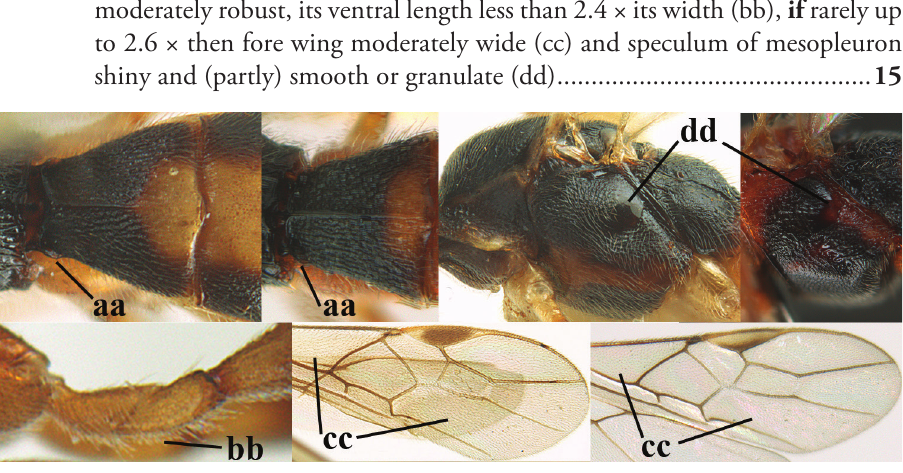
12 Tarsal claws with distinct fine pecten (a); scapus and pedicellus of ♀ at least partly blackish, contrasting with yellowish middle of antenna (b); length of malar space of ♀ 0.25–0.30 × height of eye in lateral view (c; of ♂ 0.30 times); [fourth metasomal tergite of ♀ black latero-posteriorly (of ♂ brown- ish yellow); antenna of ♀ in dorsal view bicoloured, first–eighth and 48th– 49th segments more or less dark brown, remainder of antenna yellowish, of